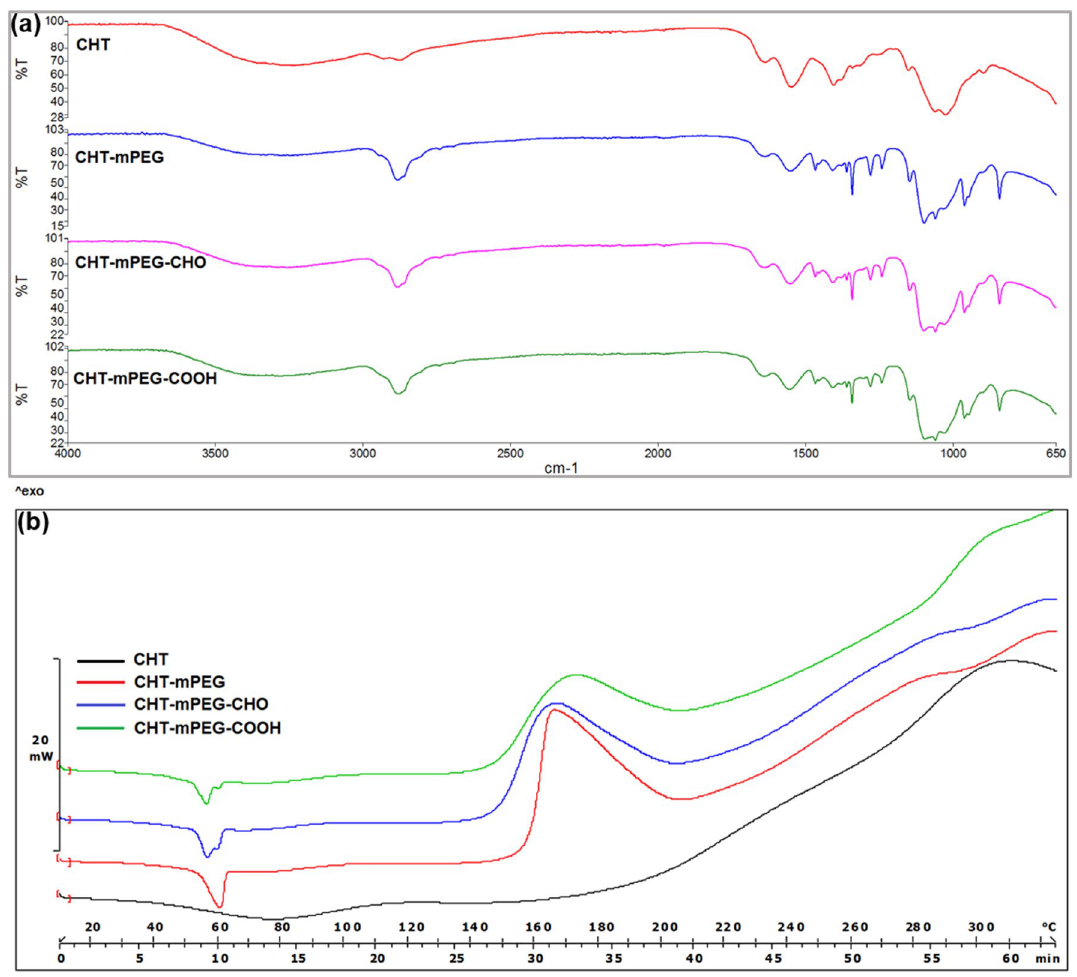
Figure 2. FTIR and DSC thermograms for CHT and CHT/mPEG cryosponges over various temperature